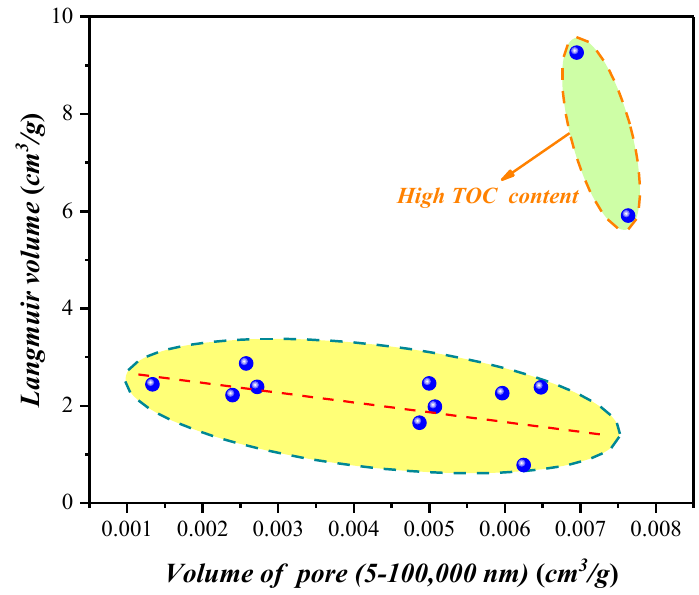
Figure 16. Relationship between methane adsorption capacity and volume of pores (5–100,000 nm) for the 12 shale samples by the high-pressure mercury injection experiment.